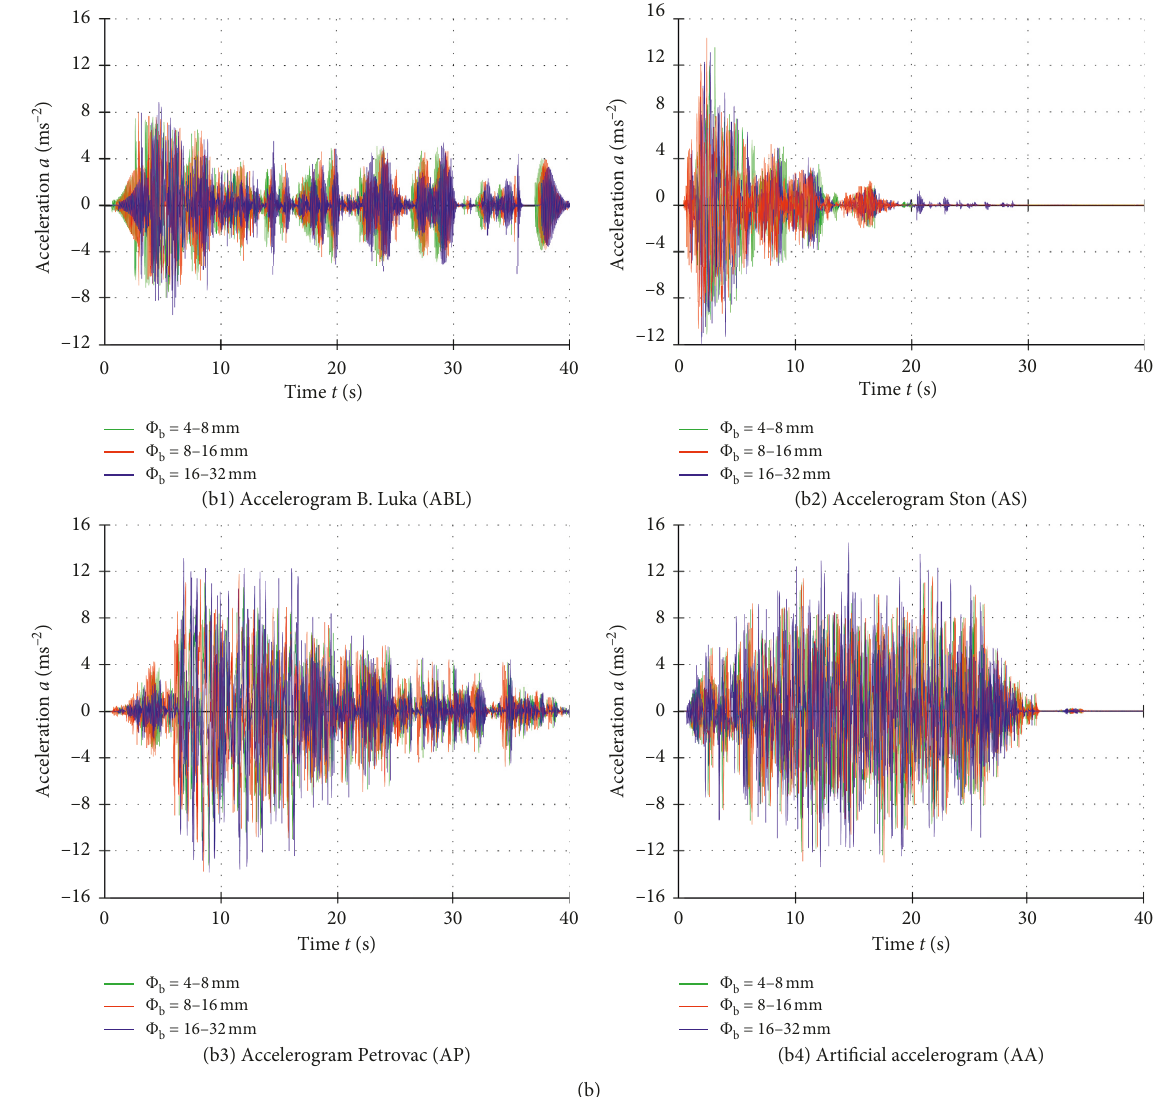
Figure 16: The effect of pebble fraction on horizontal acceleration a . (a) PGA � 0.2 g. (b) PGA � 0.6g.